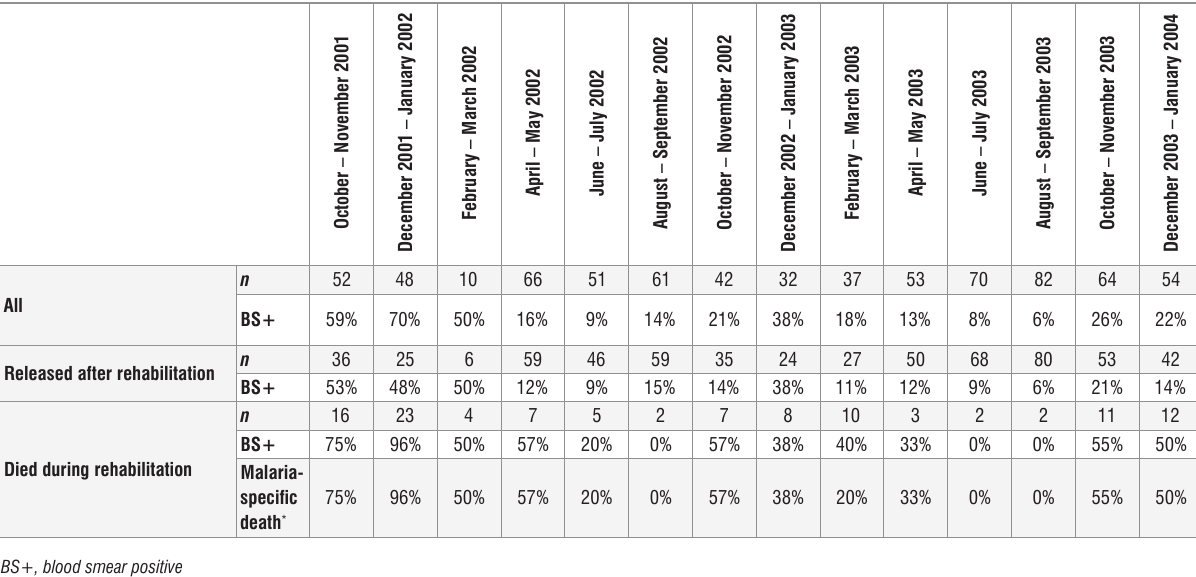
Table 1: Avian malaria blood smear data for African penguins that were eventually released and for those that died during rehabilitation at SANCCOB